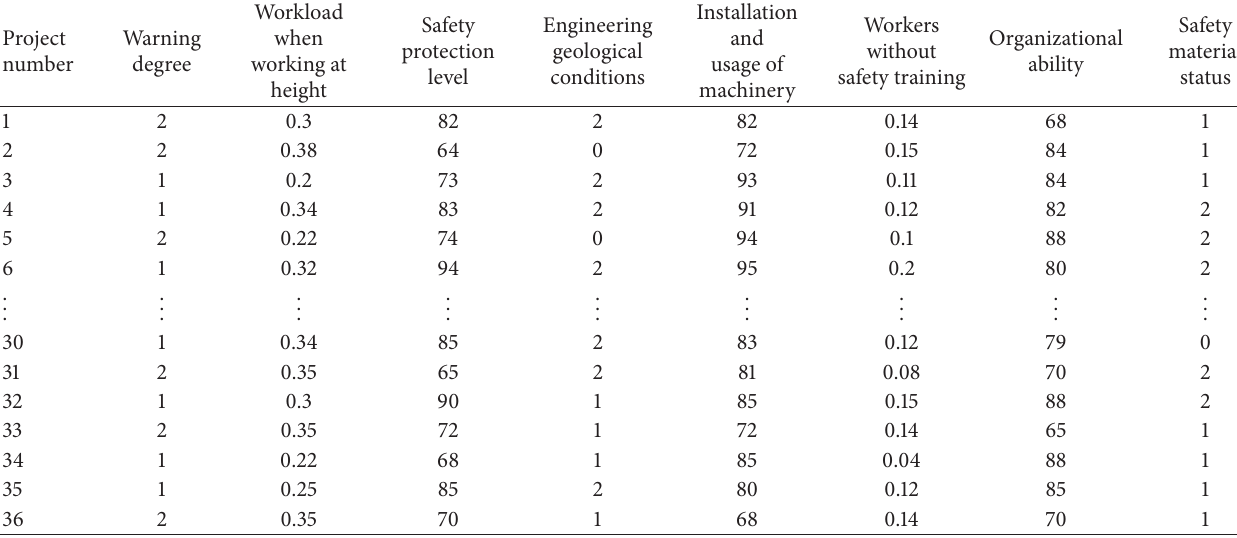
Table 2: Historical data sheet.